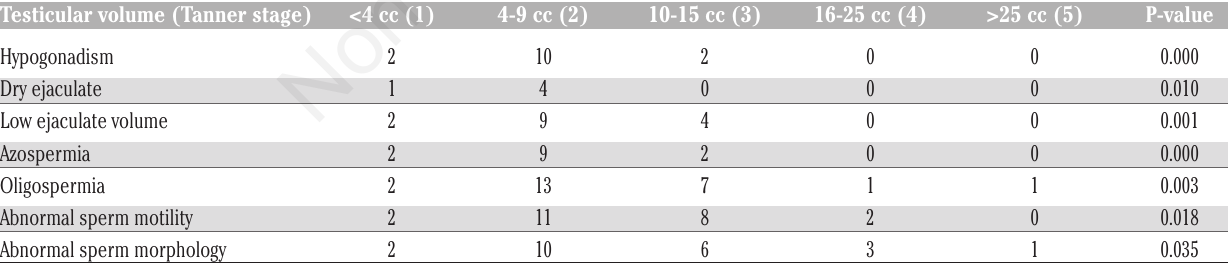
Table 2. The relationship between testicular volume and hypogonadism and sperm parameters.